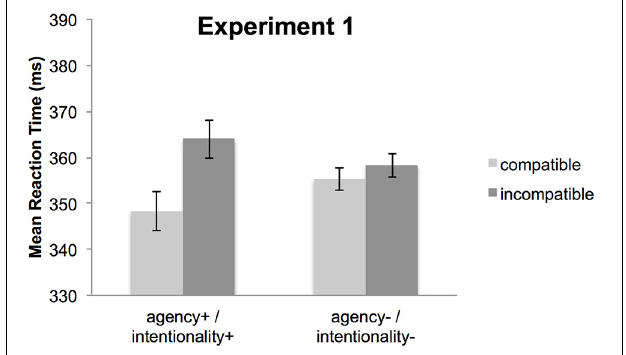
FIGURE 2 | Mean reaction times for Experiment 1. Depicted are compatible (light gray) and incompatible (dark gray) trials for the agency + /intentionality + condition (left panel) and the agency − /intentionality − condition (right panel). Error bars represent standard errors of the mean differences (Pfister and Janczyk,